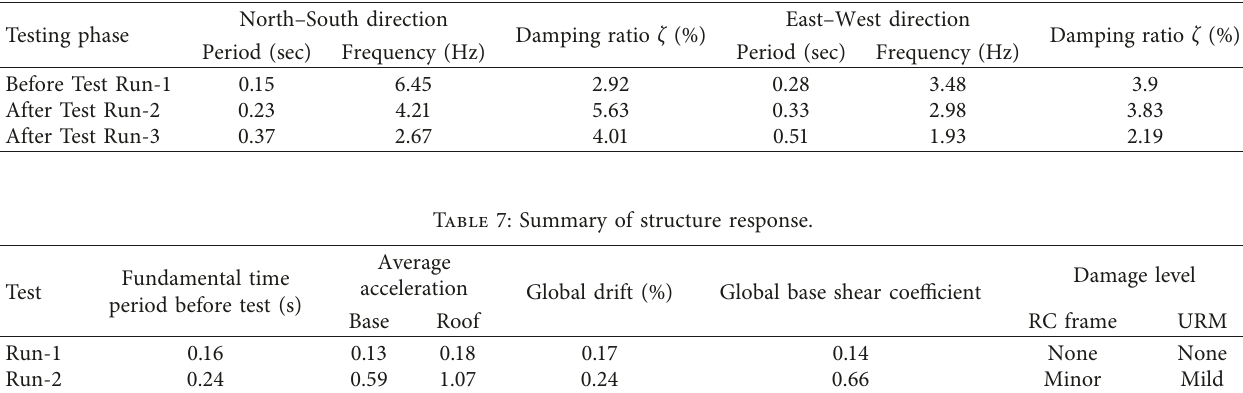
Shake table response of unreinforced masonry and reinforced concrete elements of special moment resisting